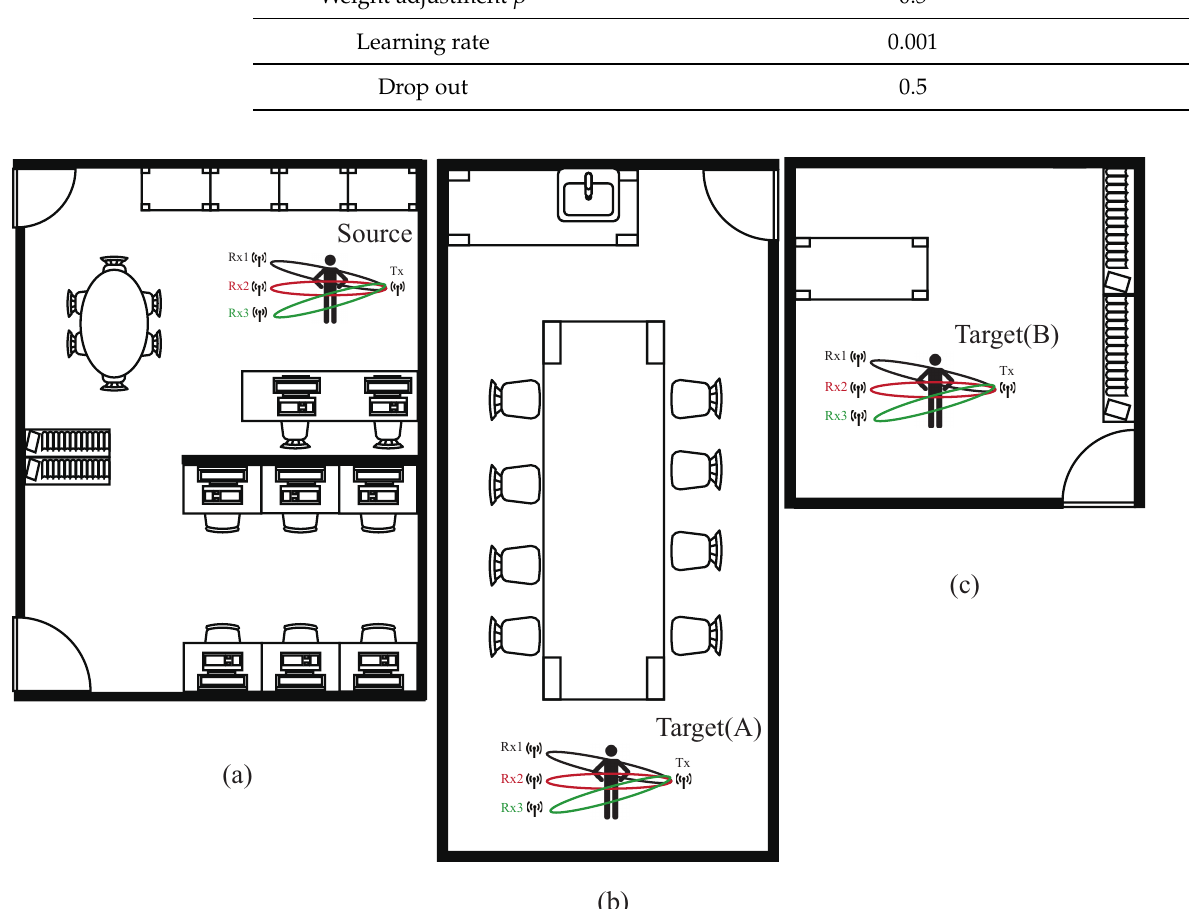
Figure 16. Layout of three experimental areas; ( a ) the source domain with the size of 5 m × 4 m, ( b ) the target domain A with big size of 10 m × 4 m, ( c ) the target domain B with the small size of 3 m × 4